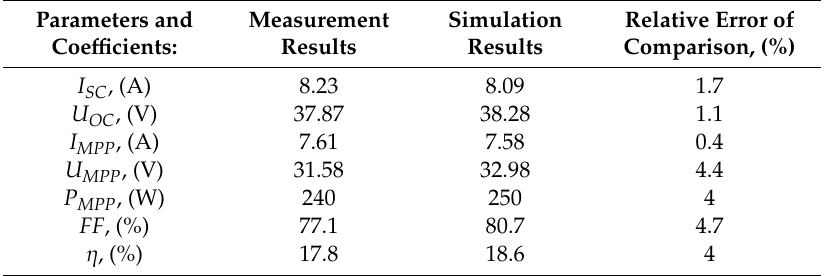
Table 3. Relative errors in the comparison of the basic parameters of the current–voltage (I–V) characteristics and the values of the fill factor ( FF ) and η coe ffi cients for the measuring point P1 graphically shown in Figure 4 (for E = 810 W / m 2 , T M = 35.5 ◦ C, and T amb = 23 ◦ C). Parameters and